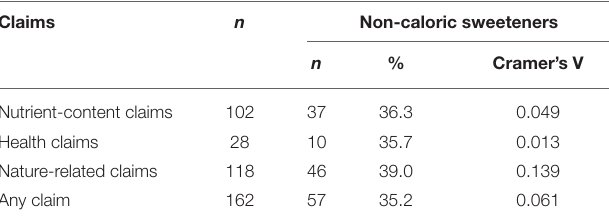
TABLE 3 | Percentage of Ready-To-Eat cereal packages with claims that have NCS. Claims n